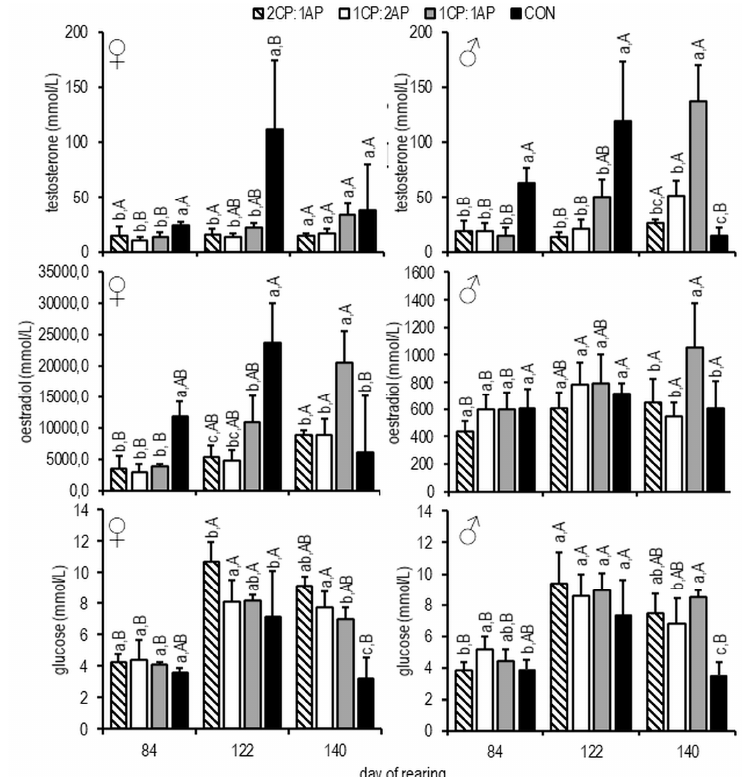
Figure 6. Glucose, testosterone, and oestradiol concentrations in the blood plasma of female